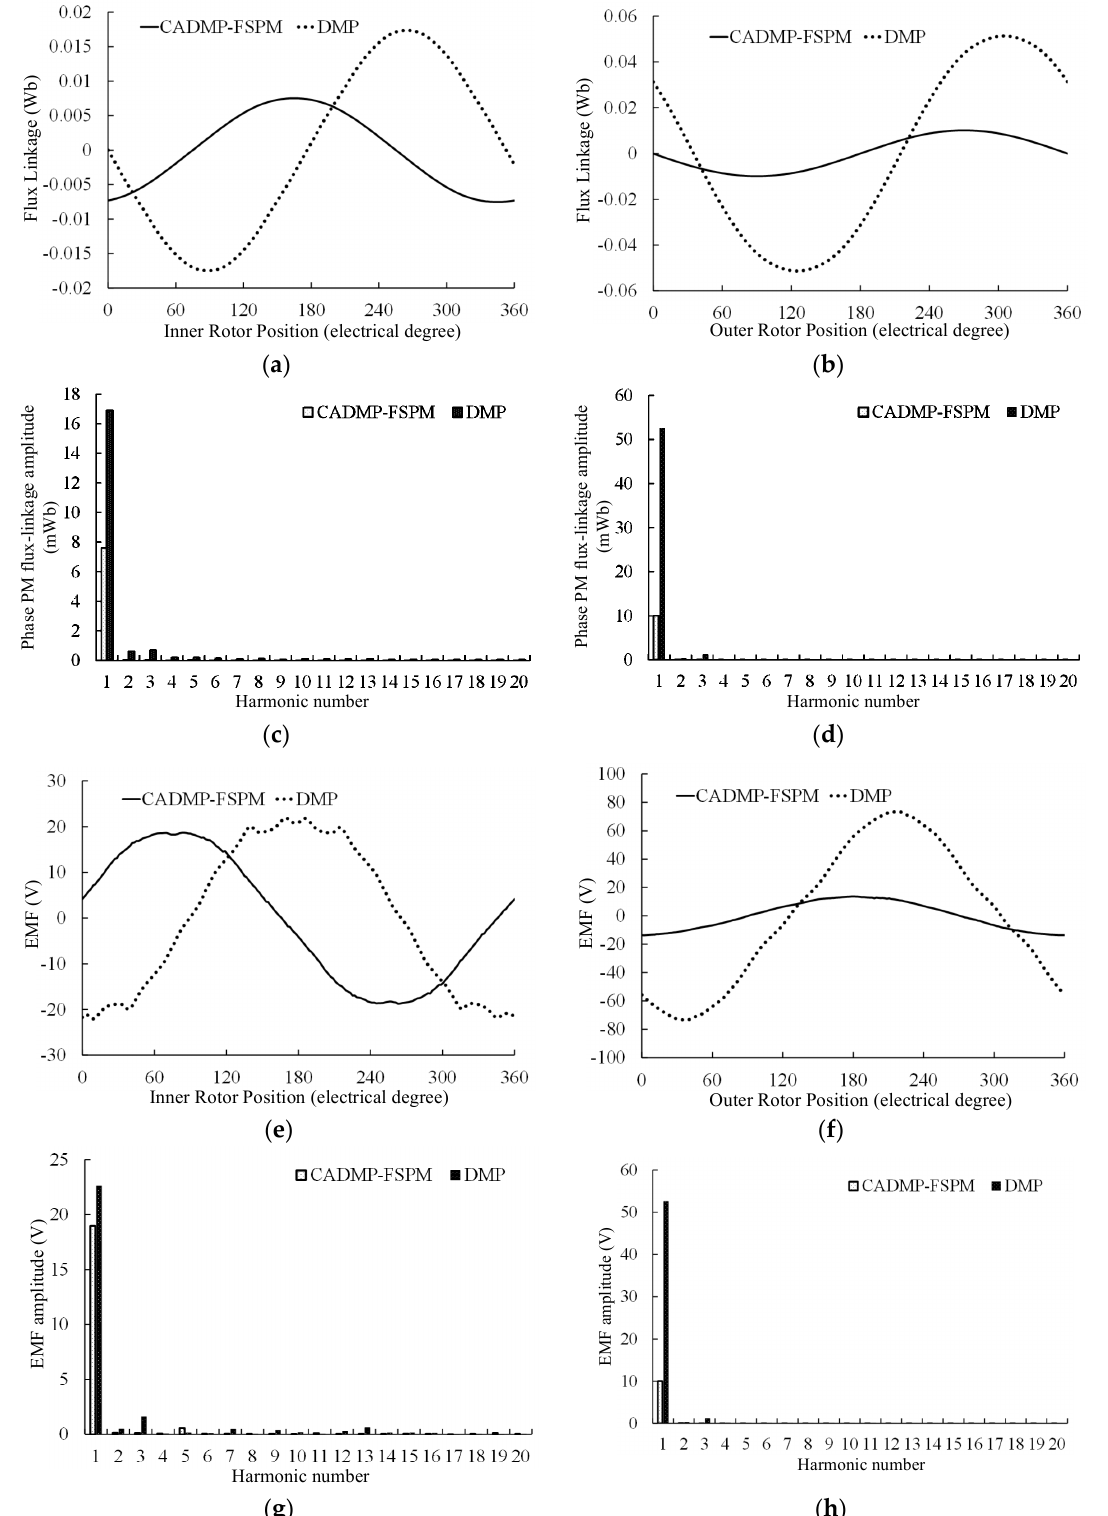
Figure 7. Phase PM fluxes and electro ‐ motive forces (EMFs) per turn of two machines. ( a ) Phase PM flux waveforms of two inner machines; ( b ) Phase PM flux waveforms of two outer machines; ( c ) The phase PM flux FFT results of two inner machines; ( d ) The phase PM flux FFT results of two outer machines; ( e ) Phase EMF per turn waveforms of two inner machines; ( f ) Phase EMF per turn waveforms of two outer machines; ( g ) The phase EMF FFT results of two inner machines; ( h ) The phase EMF FFT results of two outer machines.